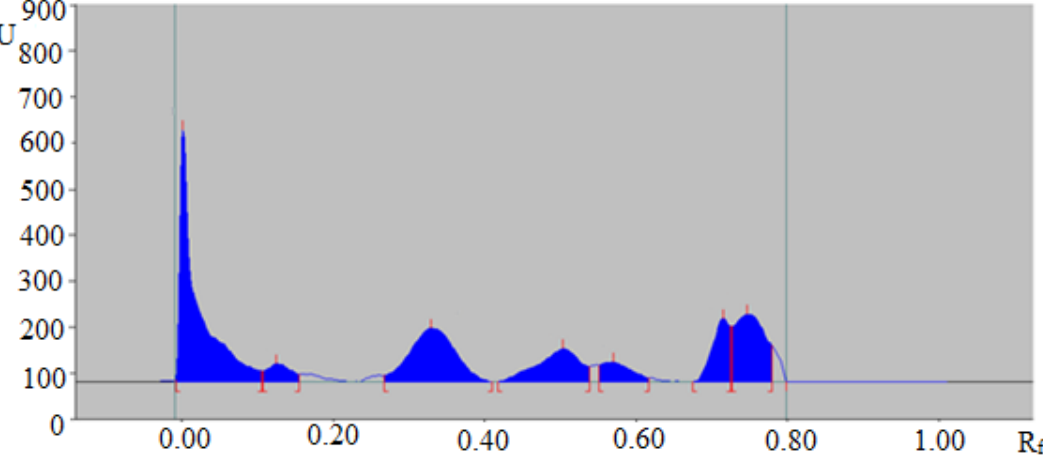
Figure 3. HPTLC chromatogram of TAL in a traditional methanolic extract of Foeniculum vulgare .